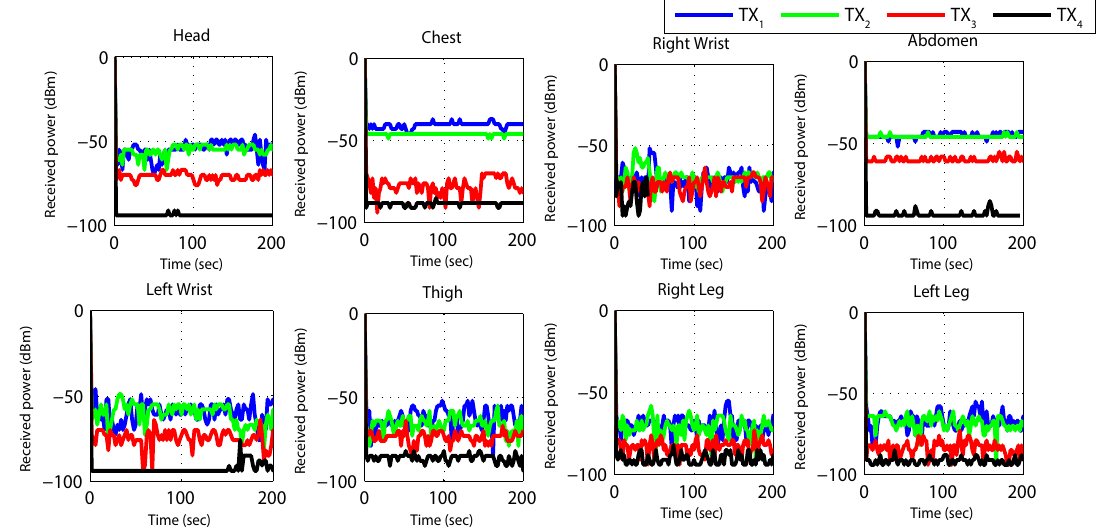
Figure 12. RX power based on default TX power while walking activity.